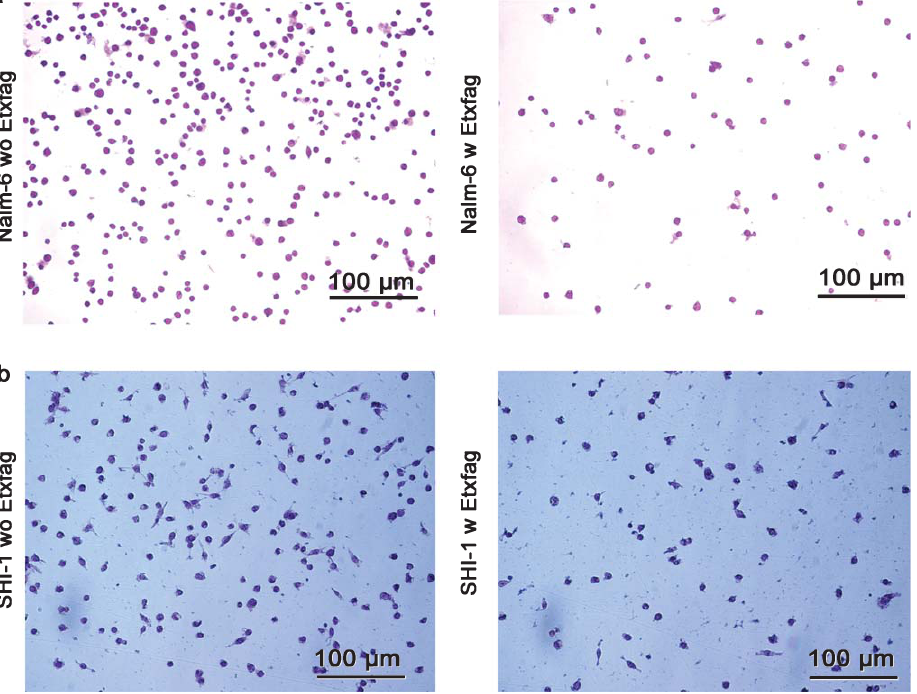
Supplementary Figure 3. Etxfag inhibits Nalm-6 and SHI-1 cell adhesion to FN/V peptide. a ) 25 × 10 4 Nalm-6 cells treated or not with 1 × 10 − 7 M etxfag for 24h were seeded on FN/V peptide (5 (cid:3) g/cm 2 ) for 2h in serum free condition. Non-adherent cells were then discarded and adherent cells stained by violet crystal were visualized by microscopy. b ) 25 × 10 4 SHI-1 cells treated or not with 1 × 10 − 7 M etxfag for 24h were seeded on FN/V peptide (5 (cid:3) g/cm 2 ) for 2h in serum free condition. Non-adherent cells were then discarded and adherent cells stained by violet crystal were visualized by microscopy. (Colours are visible in the online version of the article;